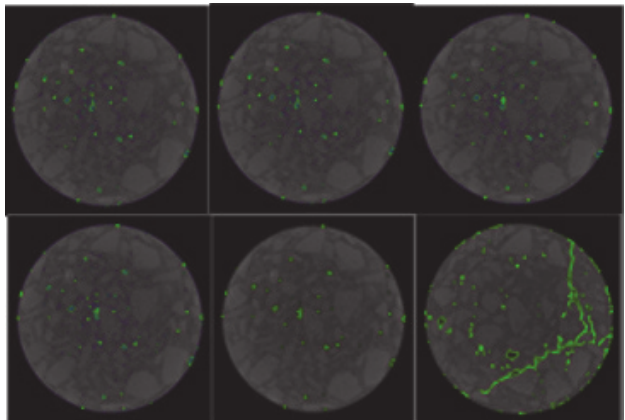
Figure 6: Threshold segmentation map of Concrete pore under different scanning